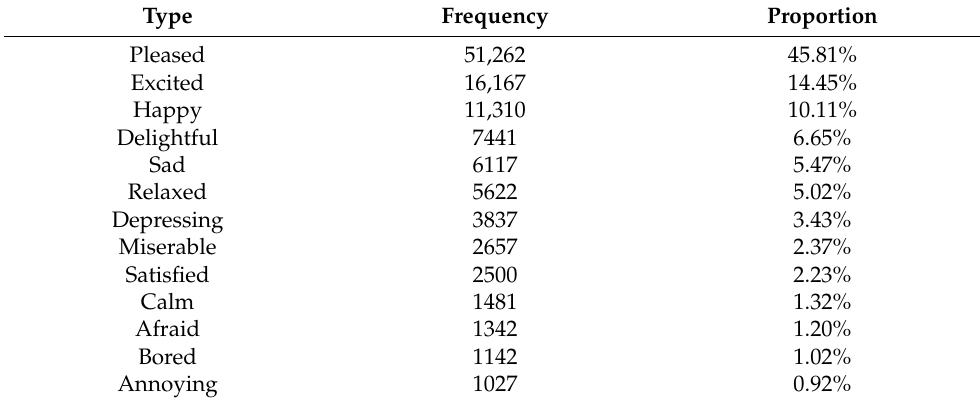
Table 3. Emotional dimension